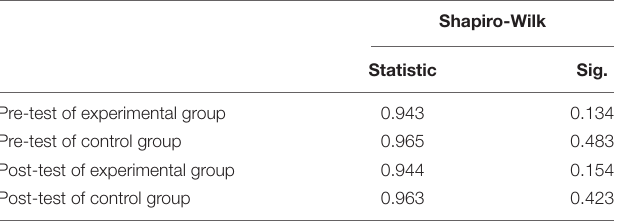
TABLE 4 | Shapiro-Wilk test normally distributed pre-test and post-test.